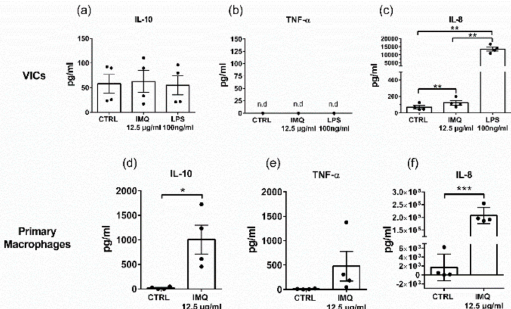
Figure 4. Cytokine response from valvular interstitial cells (VICs) and primary macrophages upon in vitro stimulation with TLR7 ligand. VICs were isolated from four aortic valves derived from patients with aortic valve stenosis. Primary human macrophages were derived from monocytes isolated from blood from four healthy donors. IL-10, TNF- α , and IL-8 were measured in the culture medium after 20-h stimulation of VICs and primary macrophages, respectively, with 12.5 µ g / mL IMQ. LPS was used as a positive control for VICs. ( a ) No significant change in IL-10 secretion was observed in VICs after IMQ stimulation. ( b ) TNF- α was below the detection level in VICs supernatant. ( c ) Significant increase of IL-8 upon stimulation with IMQ and LPS, respectively. 1-way ANOVA with Holm-Sidak post-hoc test, ** p < 0.01. ( d ) Increased IL-10 secretion by primary macrophages upon TLR7 activation. ( e ) No significant change in TNF- α secretion was observed in primary macrophages after IMQ stimulation. ( f ) Significant increase of IL-8 upon stimulation of primary macrophages with IMQ. Student´s paired t-test, * p < 0.05, *** p < 0.001. Data presented as mean ±